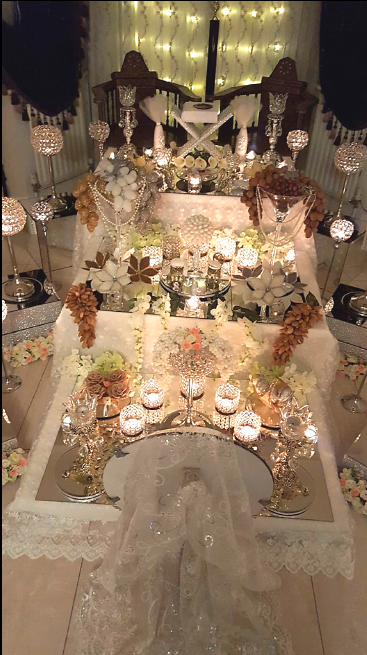
Figure 1. A sofrat al ‘aqd provided by Um Zahra in London.